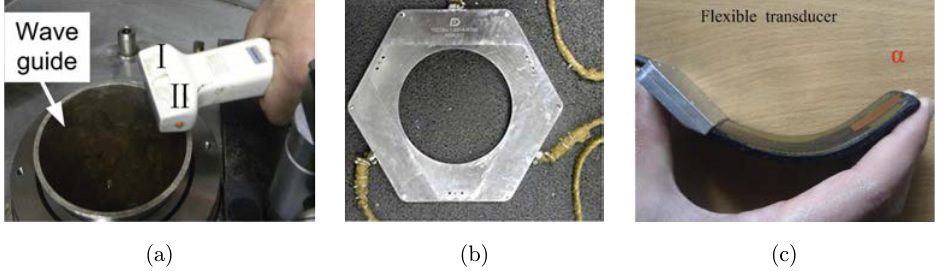
Fig. 11. Photographs of detectors. (a) Linear detector. 97 (b) Full ring detector. 91 (c) Flexible detector. 94